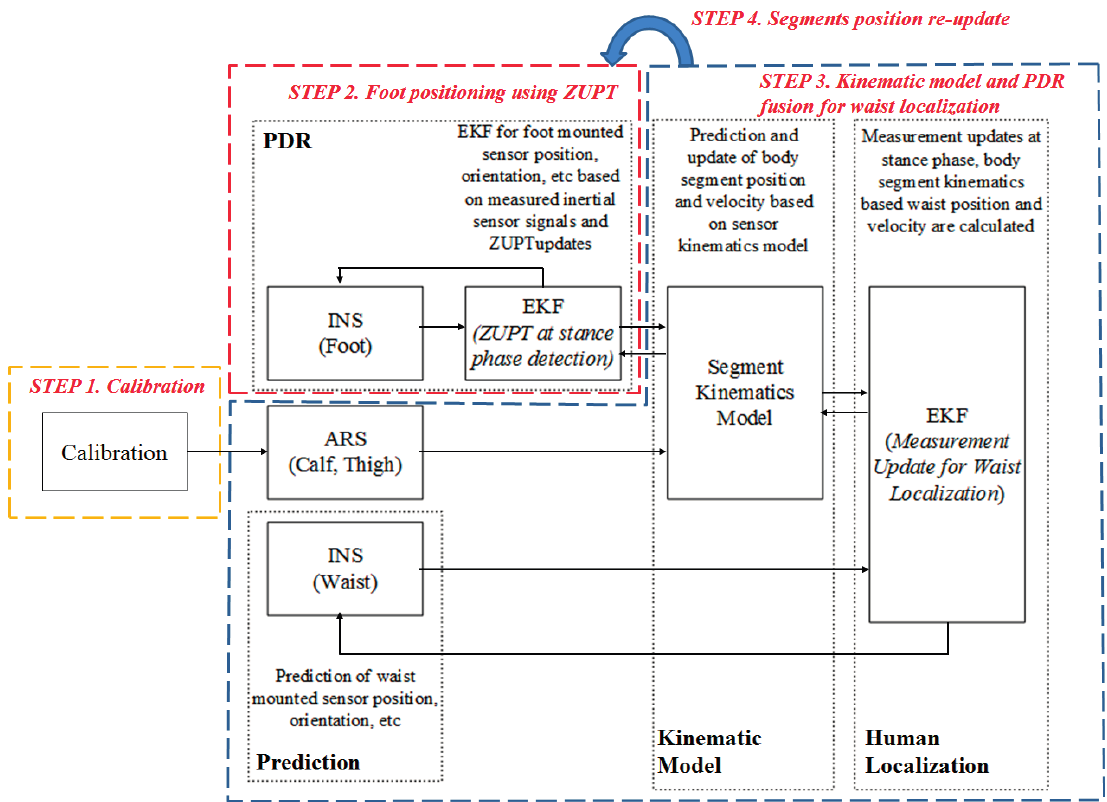
Figure 2. Block diagram of the kinematic model and PDR fusion